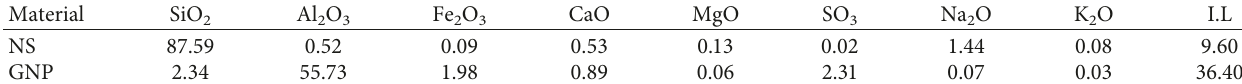
Table 1: Chemical analysis of the prepared nanosilica (NS) and gibbsite nanoparticles (GNPs) (wt%).